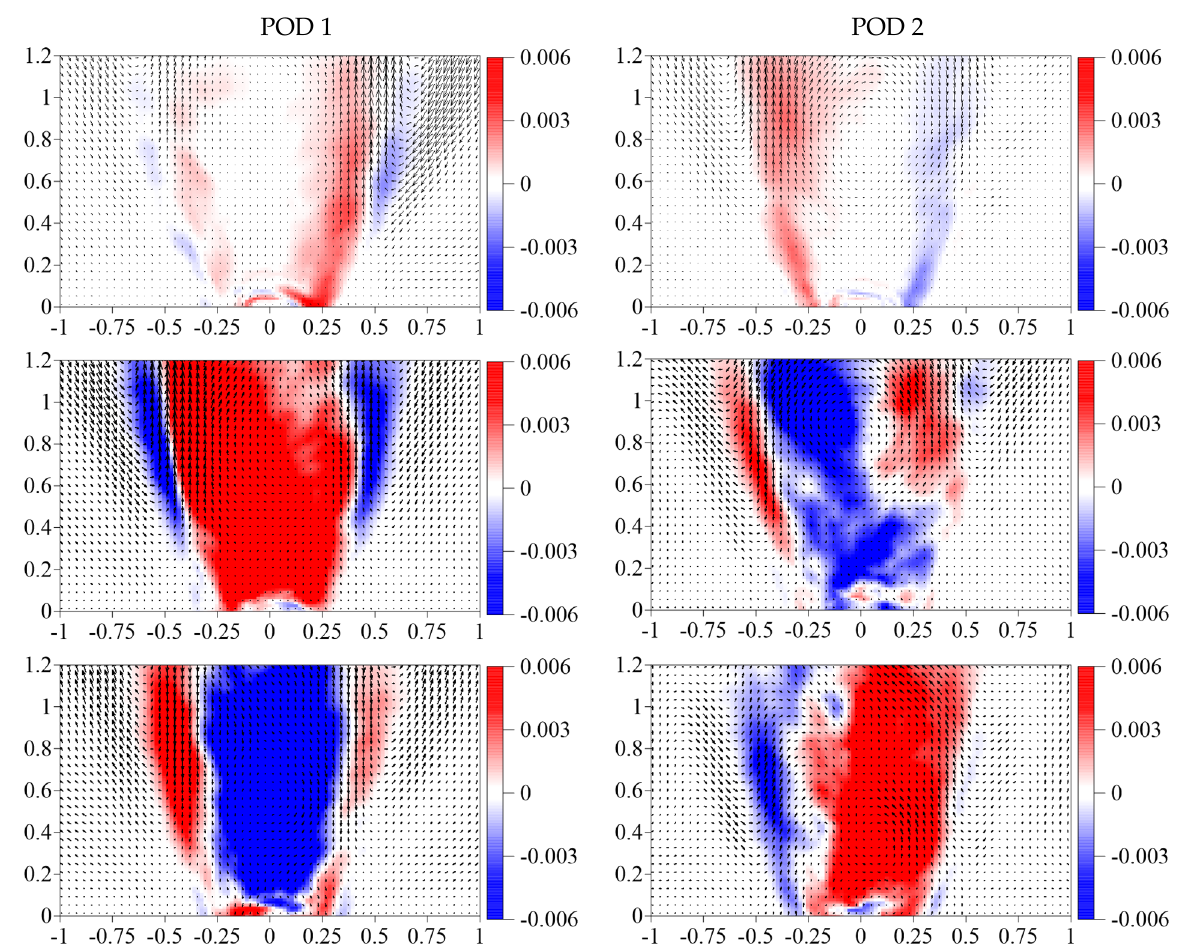
Figure 13. The first and the second POD modes with the conditionally sampled CO concentration: the first line—1 atm. 293 K; the second line—2 atm. 500 K; the third line—3.4 atm. 500 K.